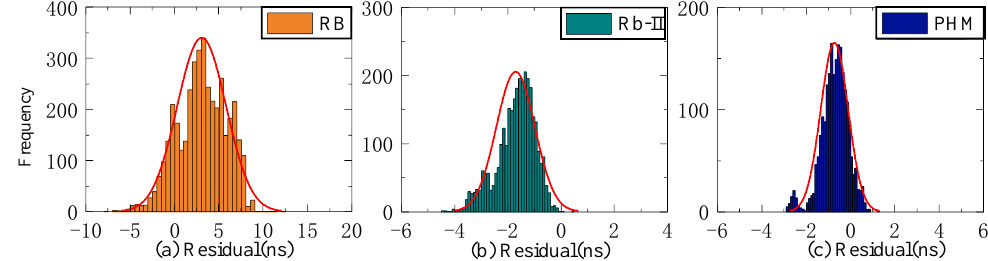
Figure 7. The ISUO-ISC residuals of three atomic clocks. ( a ) The residual distribution of the RB clock. ( b ) The residual distribution of the Rb-II clock. ( c ) The residual distribution of the PHM clock.